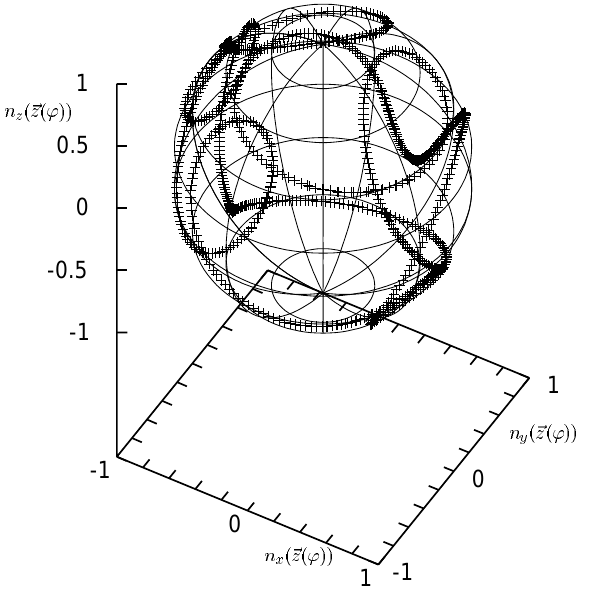
FIG. 7. An invariant curve of spin-orbit motion in HERA at 820 GeV (cid:1) c for a normalized vertical emittance of 16 p mm